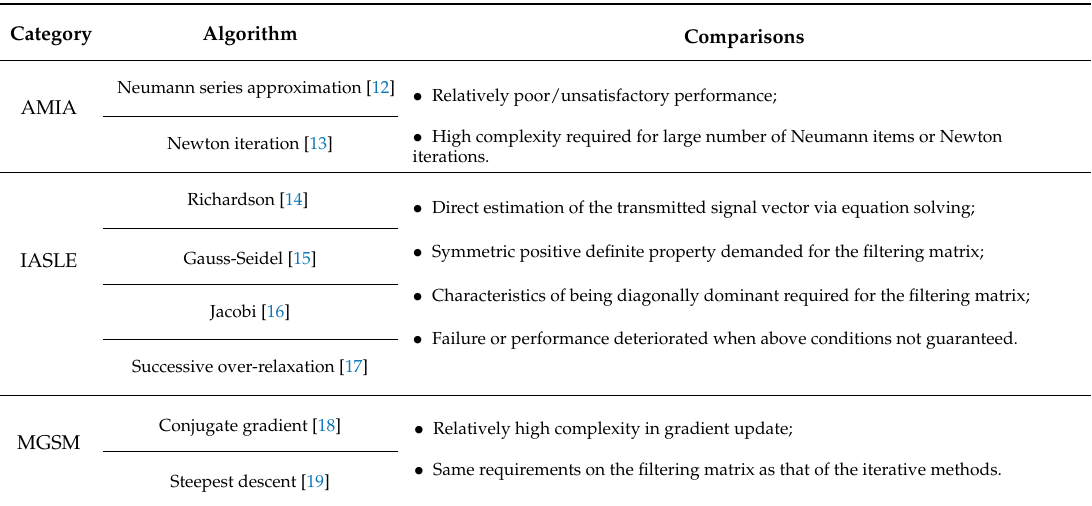
Table 1. Minimum mean square error (MMSE) criterion-based low complexity signal detection